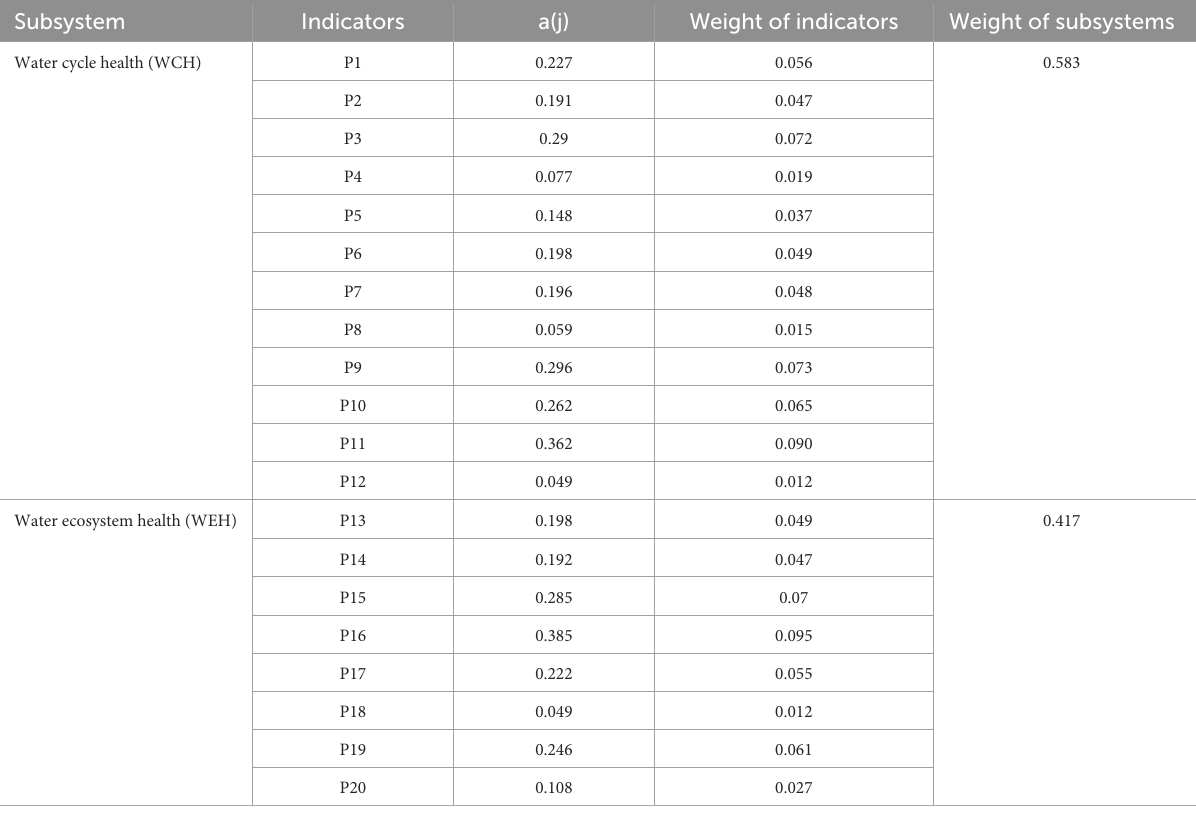
TABLE 3 Each component a ( j ) of the projection vector E a and the weights of indicators.